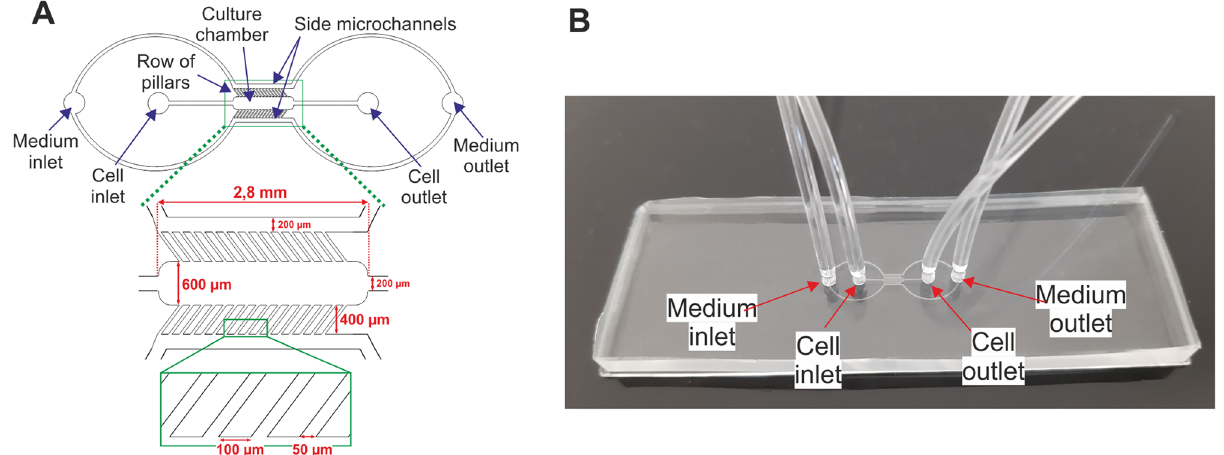
Figure 1. ( A ) A geometry of the designed microsystem with the dimensions of the microstructures. ( B ) The fabricated microsystem.